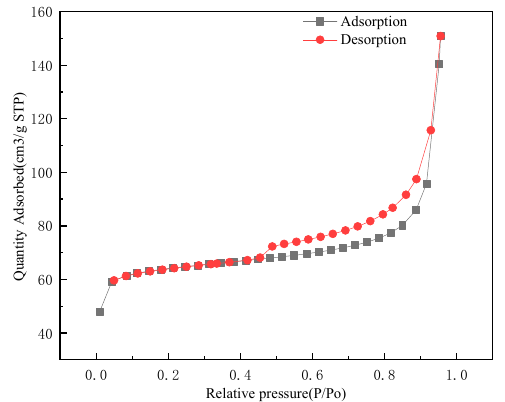
Figure 5. Isotherms of MGO@ZIF-8.